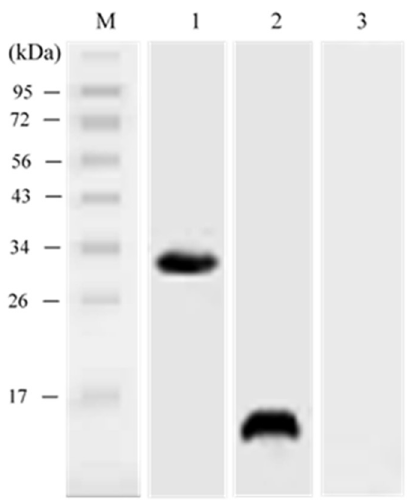
Figure 4. In vitro detection of pcHrp1 and pcIL-34 by Western blot. Lane M: protein ladder; lane 1: lysate of E11 cells transfected with pcIL-34; lane 2: lysate of E11 cells transfected with pcHrp1; lane 3: lysate of E11 cells transfected with pcDNA3.1 (negative control).